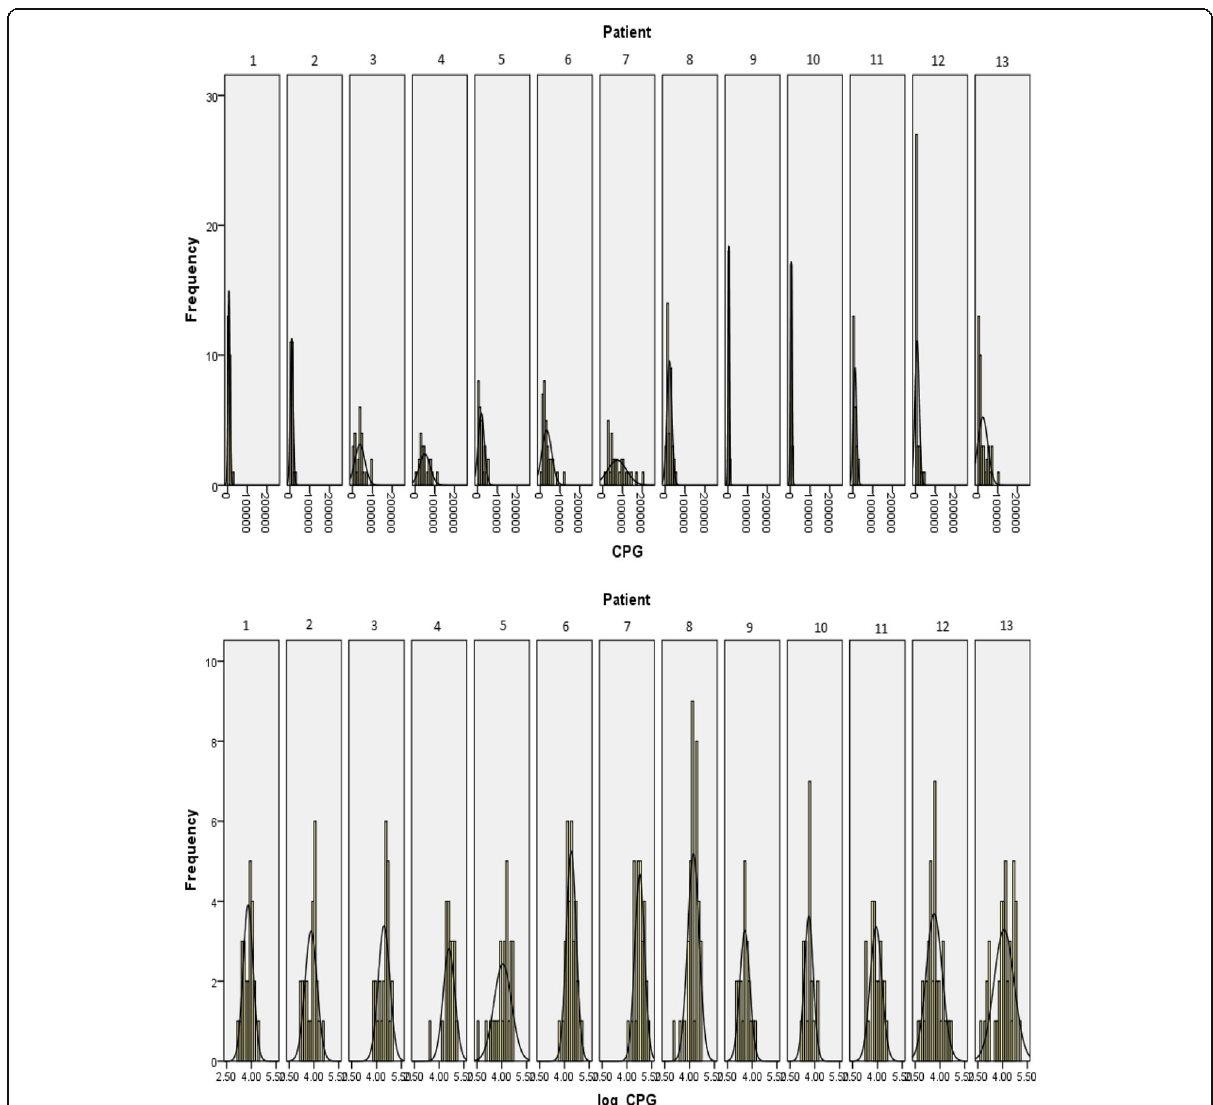
Fig. 1 Histograms showing the data distribution of 35-S uptake of each patient before and after log